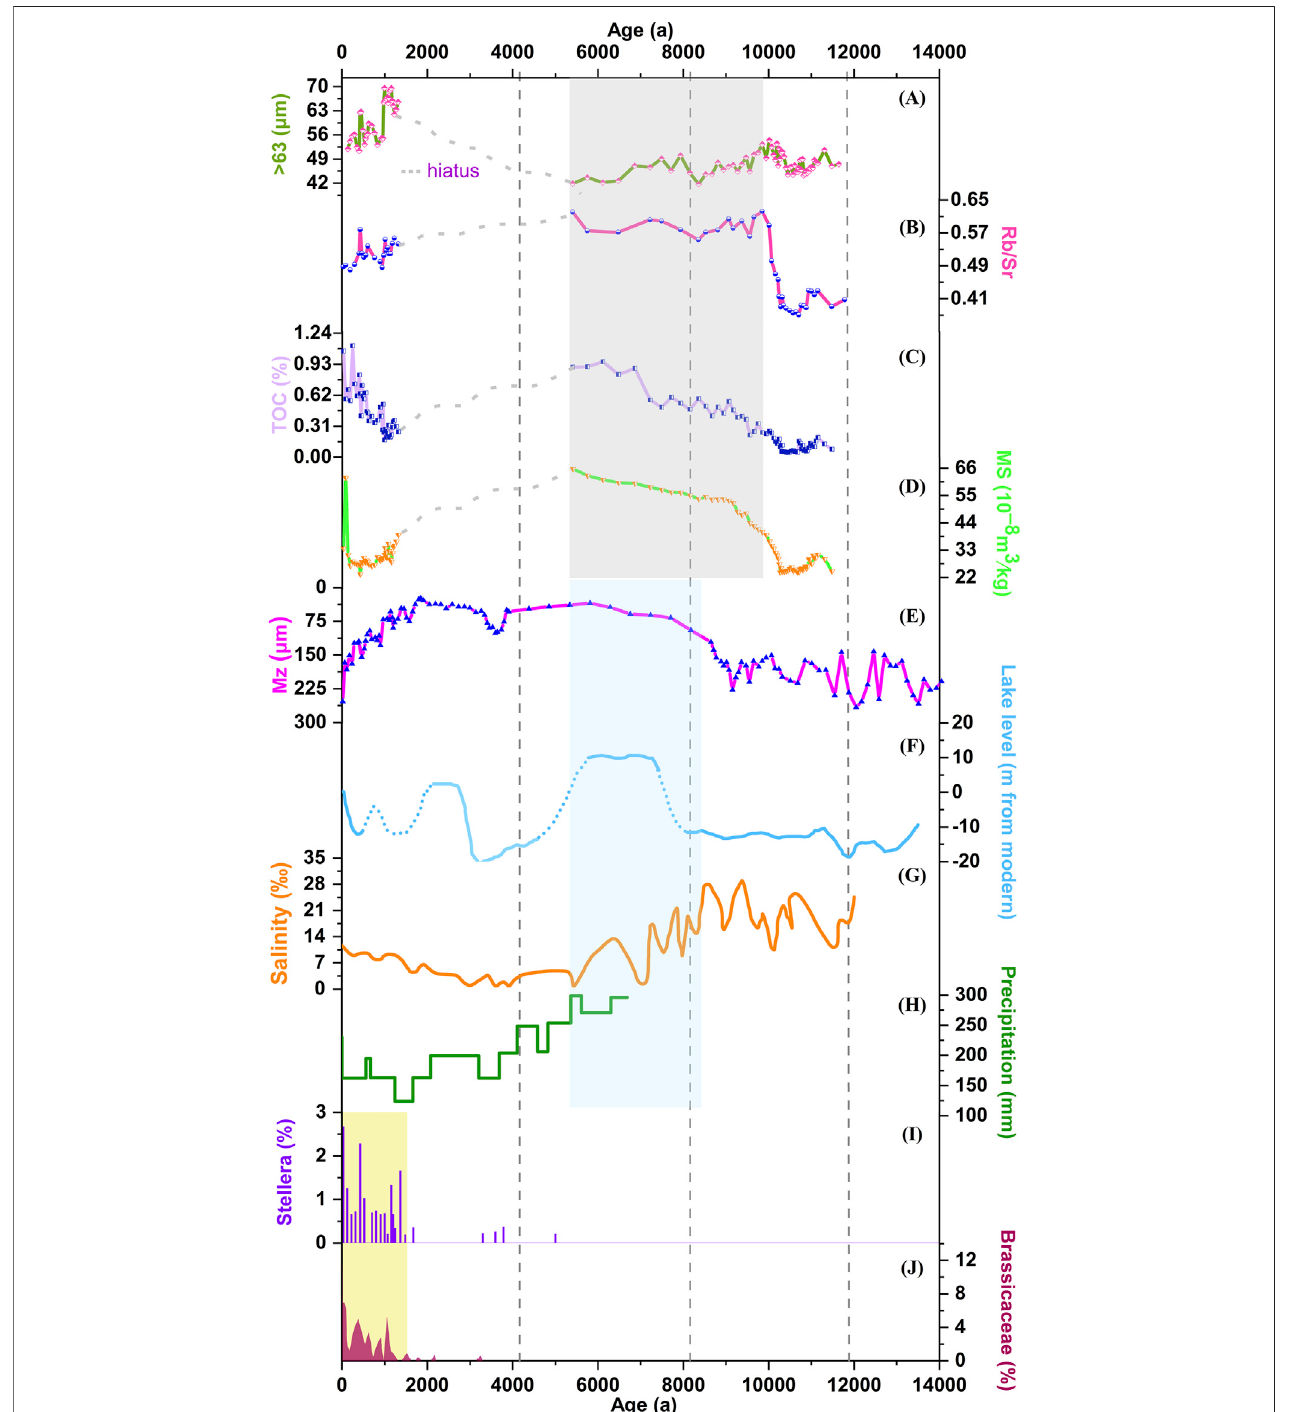
FIGURE7| ComparisonofproxyindicatorsfortheNJsectionwithpublishedpaleoclimaterecordsforothersitesontheNortheastQinghai-TibetPlateau(NE-QTP) (ages based on the Undatable model). (A) > 63 μ m content, NJ section. (B) Rb/Sr, NJ section. (C) Total organic carbon (TOC), NJ section. (D) Low frequency magnetic susceptibility (MS), NJ section. (E) Mean grain size (Mz), ND section, Qinghai Lake (E et al., 2019). (F) Lake level, core KH17, Kuhai Lake (Yan et al., 2018). (G) Salinity, Qinghai Lake (Zhang et al., 1989). (H) Precipitation, tree ring DLH, Qilian Mountains (Yang et al., 2021). (I) Stellera pollen, core GGHA, Gonghe Basin (Liu et al., 2016). (J) Brassicaceae pollen, core GGHA, Gonghe Basin (Huang et al., 2017).